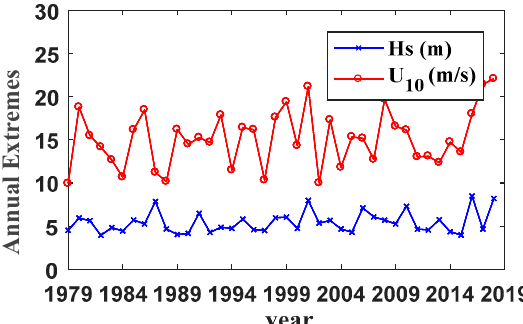
Figure 15. Maximum significant wave height H s and wind speed U 10 by years.